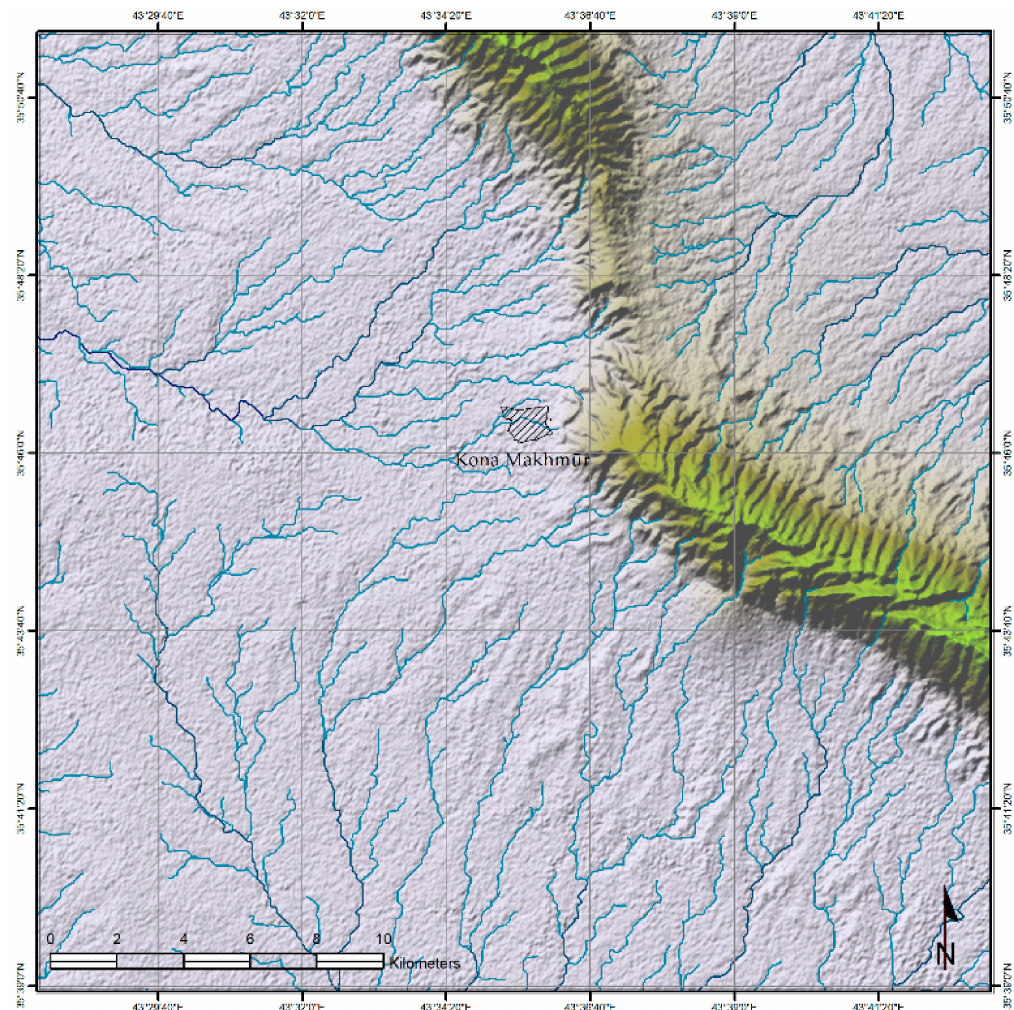
Figure 6. Hydrology of the Kona Makhm¯ur site and its surroundings based on the ALOS Palsar digital elevation model (DEM) (12.5 m resolution) (author: Lenka Starkov á